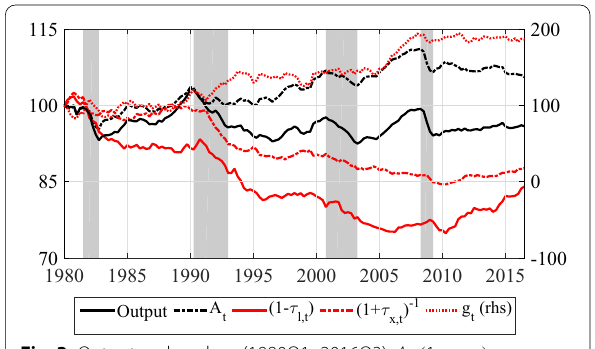
Fig. 3 Output and wedges (1980Q1–2016Q3). A t , ( 1 − τ l , t ) , ( 1 + τ x , t ) − 1 and g t denote the efficiency, labour, investment, and government